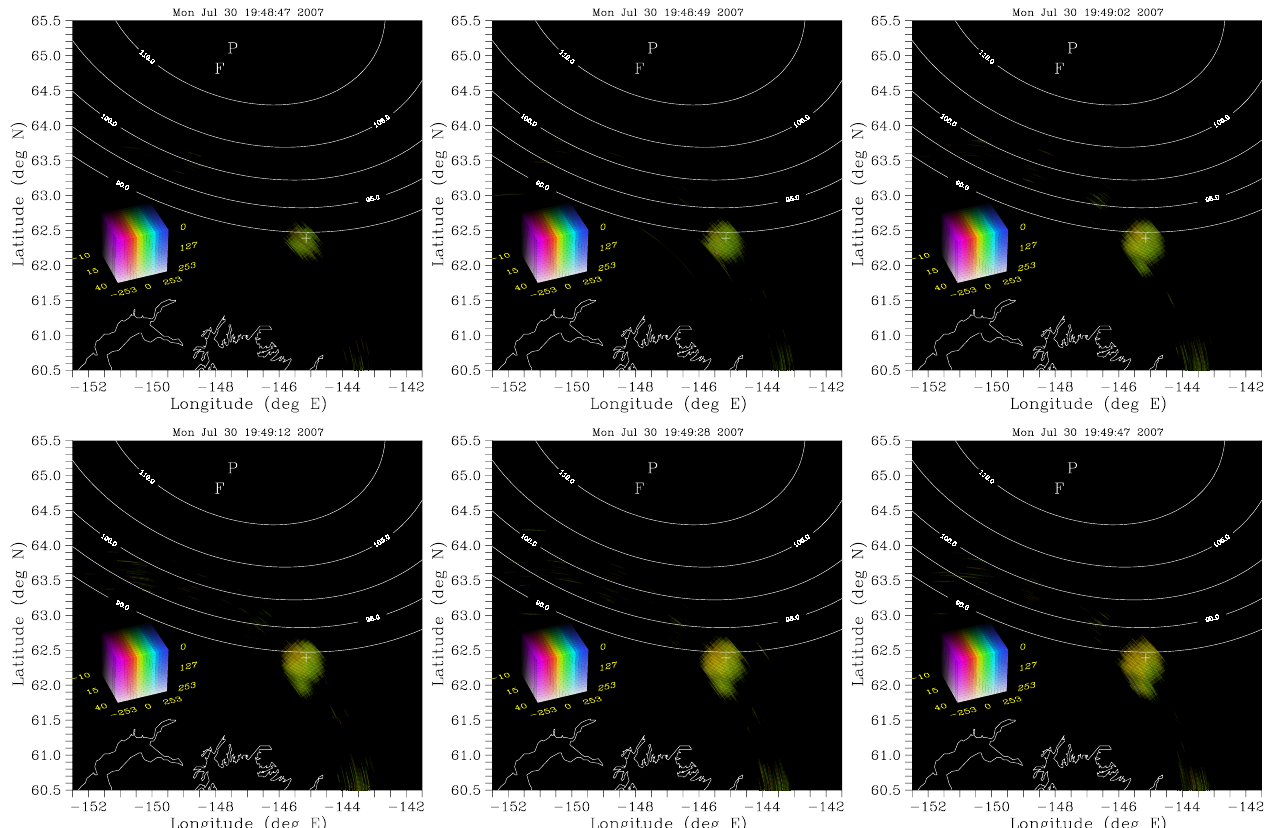
Fig. 7. Radar images illustrating the temporal evolution of artificial E region FAIs in the heater-modified volume. Contours mark the locus of perpendicularity in the absence of refraction. The HAARP site is indicated by the “+” symbol. The color legend associates pixel brightness, hue, and saturation with signal-to-noise ratio ( − 10–40dB), Doppler shift ( ± 253m/s), and spectral width (0–253m/s),